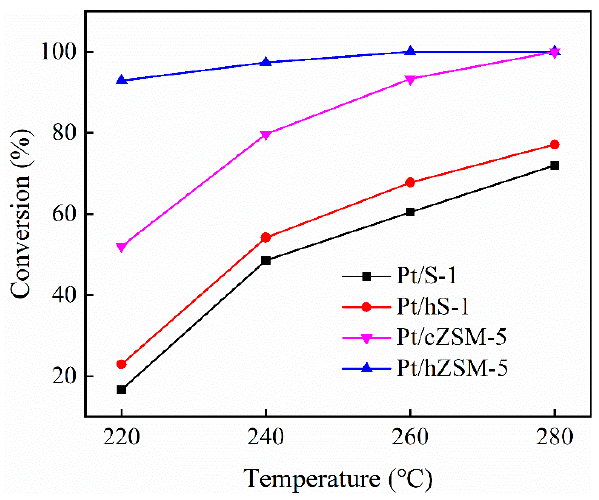
Figure 7. Conversion of guaiacol as a function of temperature over different Pt catalysts.